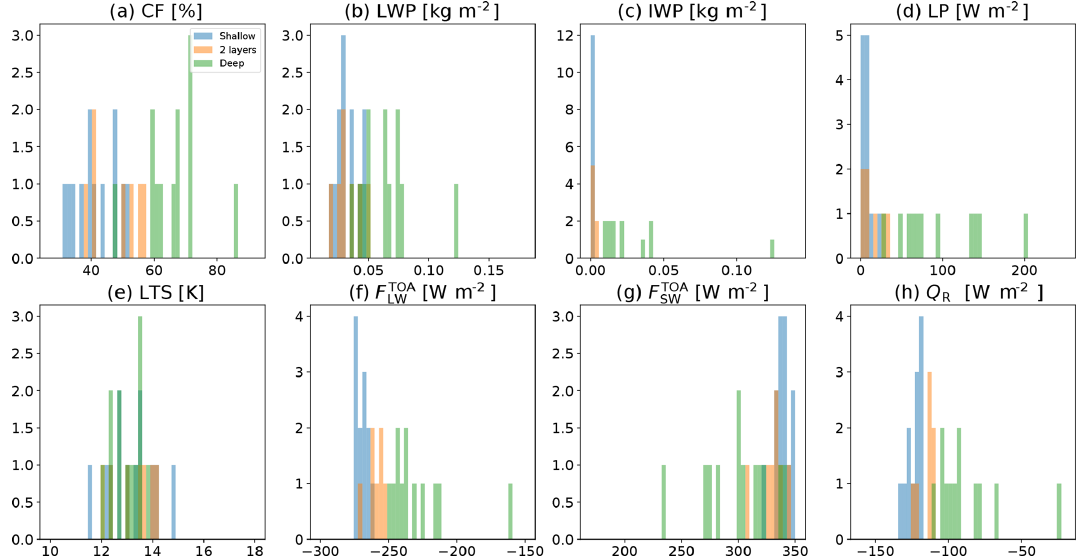
Figure 7. Same as Fig. 6 but for the NARVAL 2 month (August